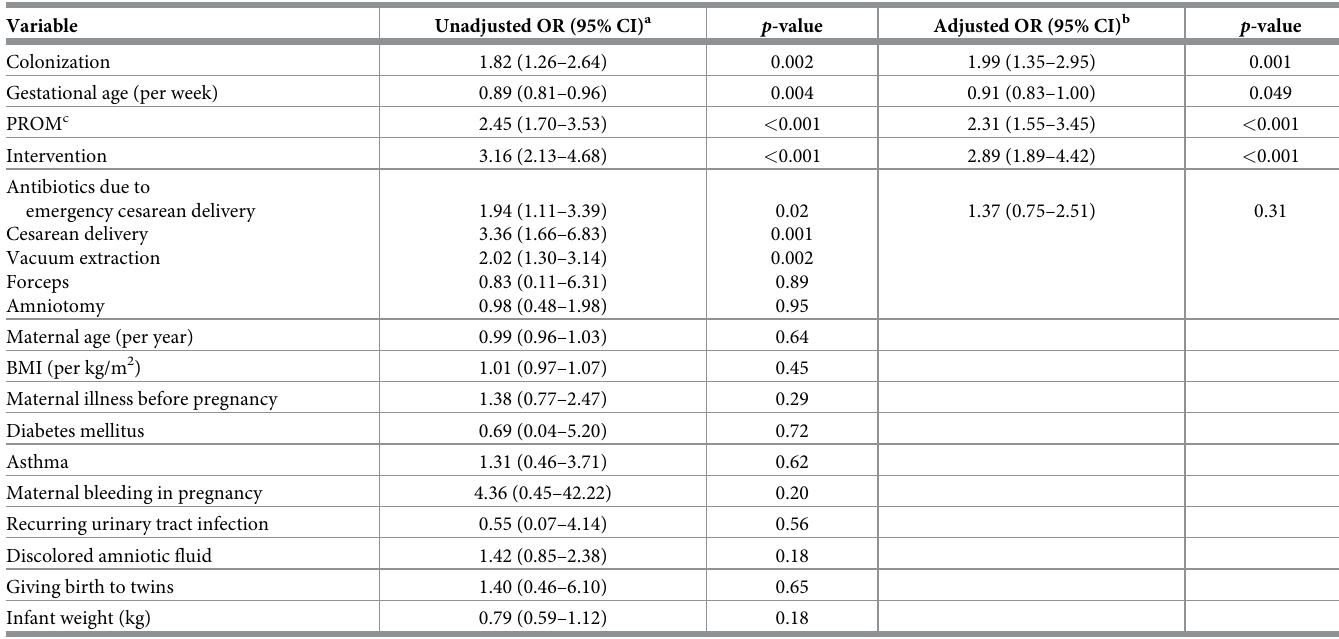
Table 2. Unadjusted and adjusted odds ratios for maternal peripartum